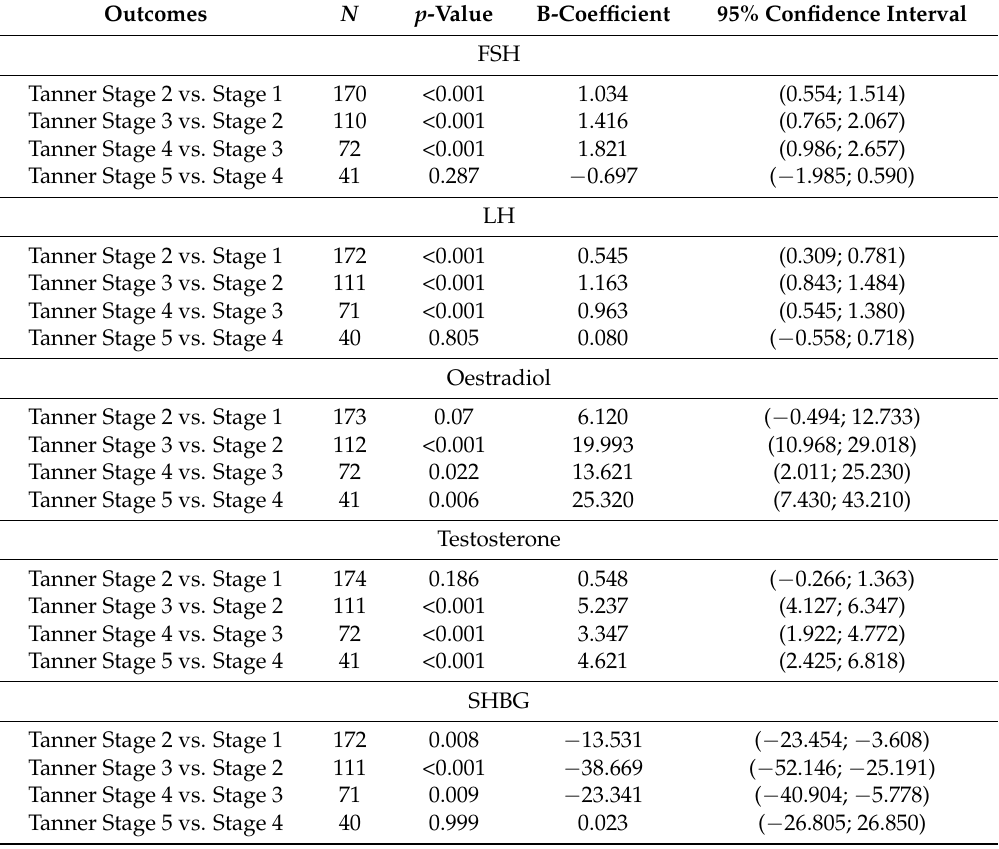
Table 5. Multivariate Linear Regression relationship between tanner stage and reproductive hormone levels for boys in the rural Western Cape after adjusting for lived on farm or not, family income, general health condition, and ever had any testicular related